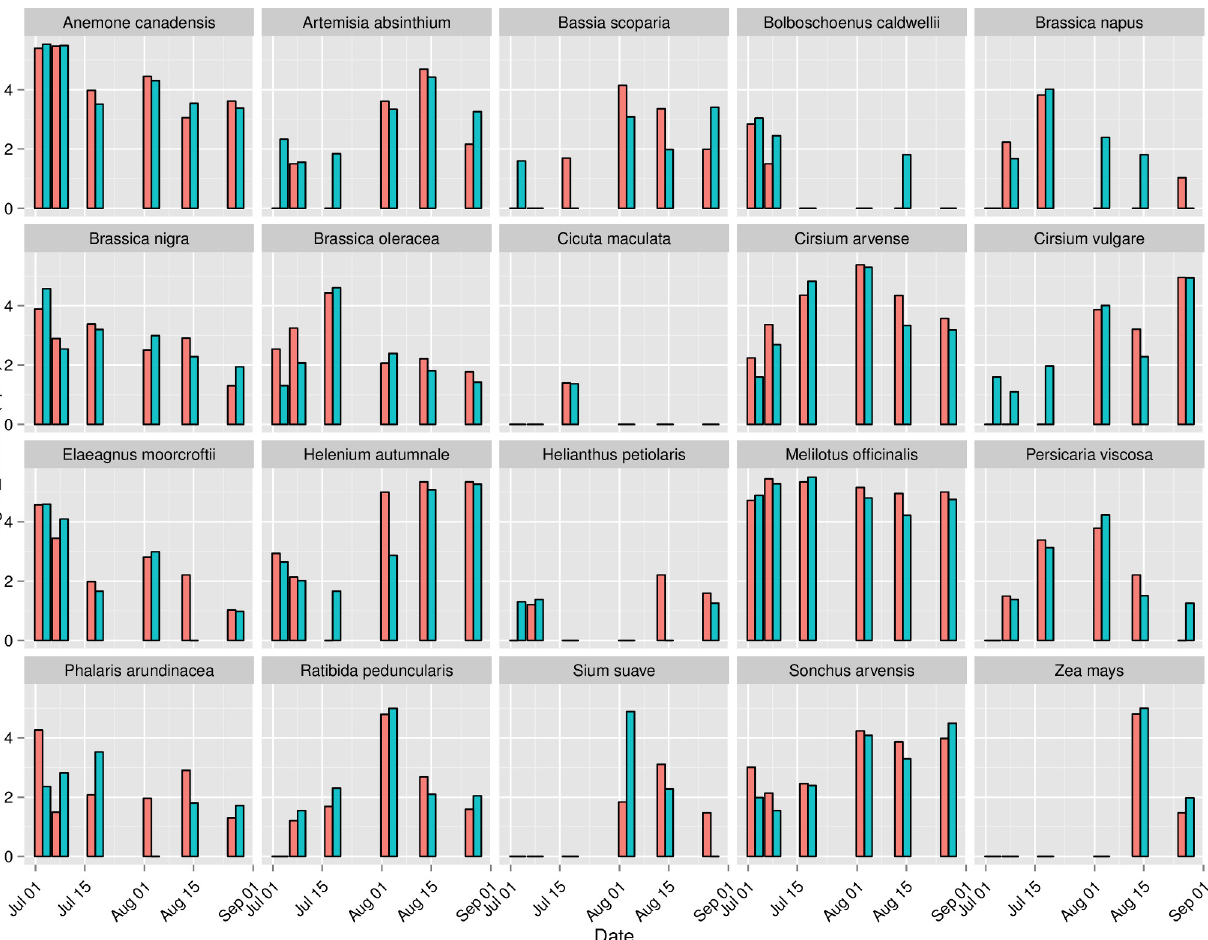
Fig 4. Forage calendar for two honey bee colonies (red and blue bars) located in Apiary 3 in 2009, highlighting the temporal progression of plant taxa. Combined OTU counts for the 20 most common plant species-level assignments, based on the summed counts for all apiaries in 2009, are represented. Vertical axis represents the log 10 transformed counts per million mapped reads (cpm) for each taxon at each sampling point.